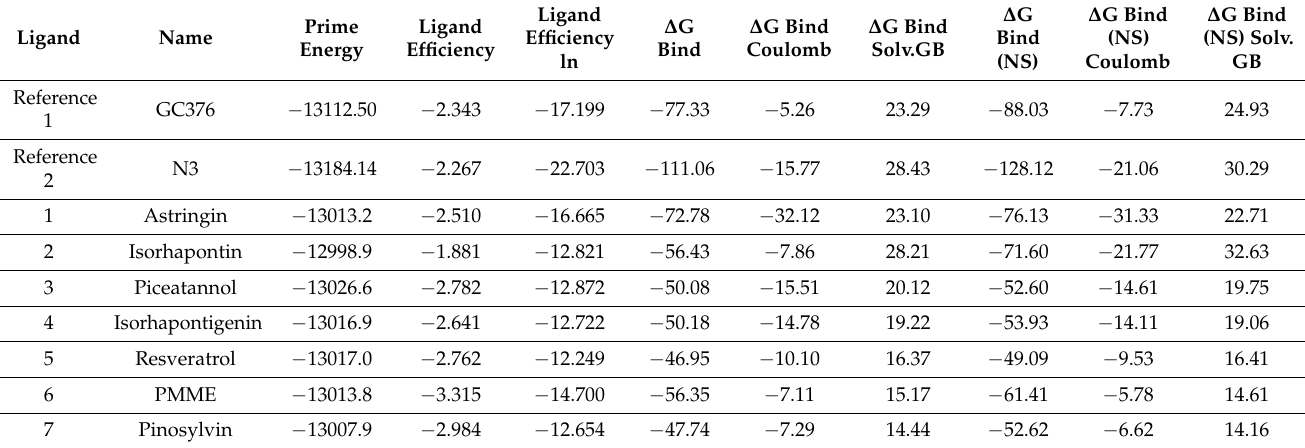
Table 5. Prime MM-GBSA results for reference and stilbene compounds binding to M pro